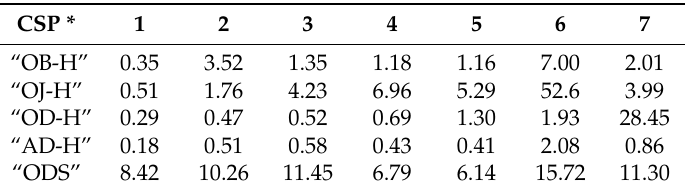
Table 1. Relative retention of terphenyl and polycondensed aromatic hydrocarbon (PAH) isomers. See Scheme 1 for analyte